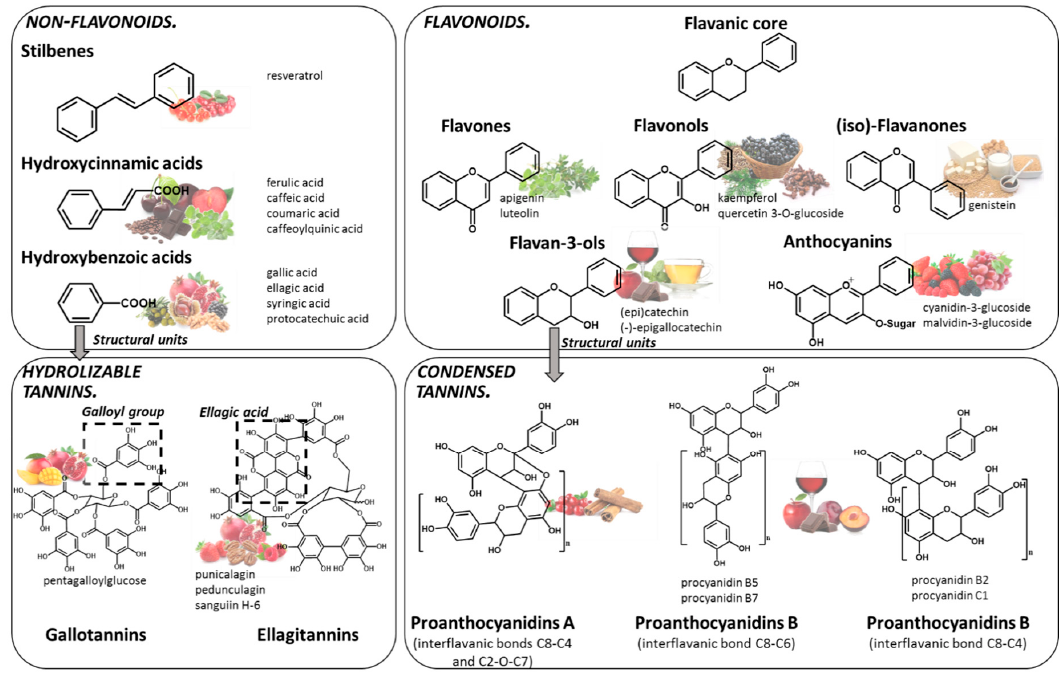
Figure 1. Chemical structure of the main families of polyphenols and some of the main food sources rich in each class: stilbenes (lingonberry, redcurrant), hydroxycinnamic acids (plums, coffee, chocolate, sweet cherry, broccoli, oregano, spearmint), hydroxybenzoic acids (pomegranate, blackberry, chestnut, walnut, olive), gallotannin (mango, pomegranate), ellagitannins (pomegranate, strawberry, pecan, raspberry, cloudberry), flavones (marjoram, oregano, sage), flavonols (black chokeberry, cloves, cumin), (iso)-flavanones (soy-based products), flavan-3-ols (tea, apples, wine, chocolate), anthocyanins (red raspberry, blackcurrant, red grapes, strawberries), proanthocyanidins (wine, plums, cranberries, chocolate, apple, cinnamon).